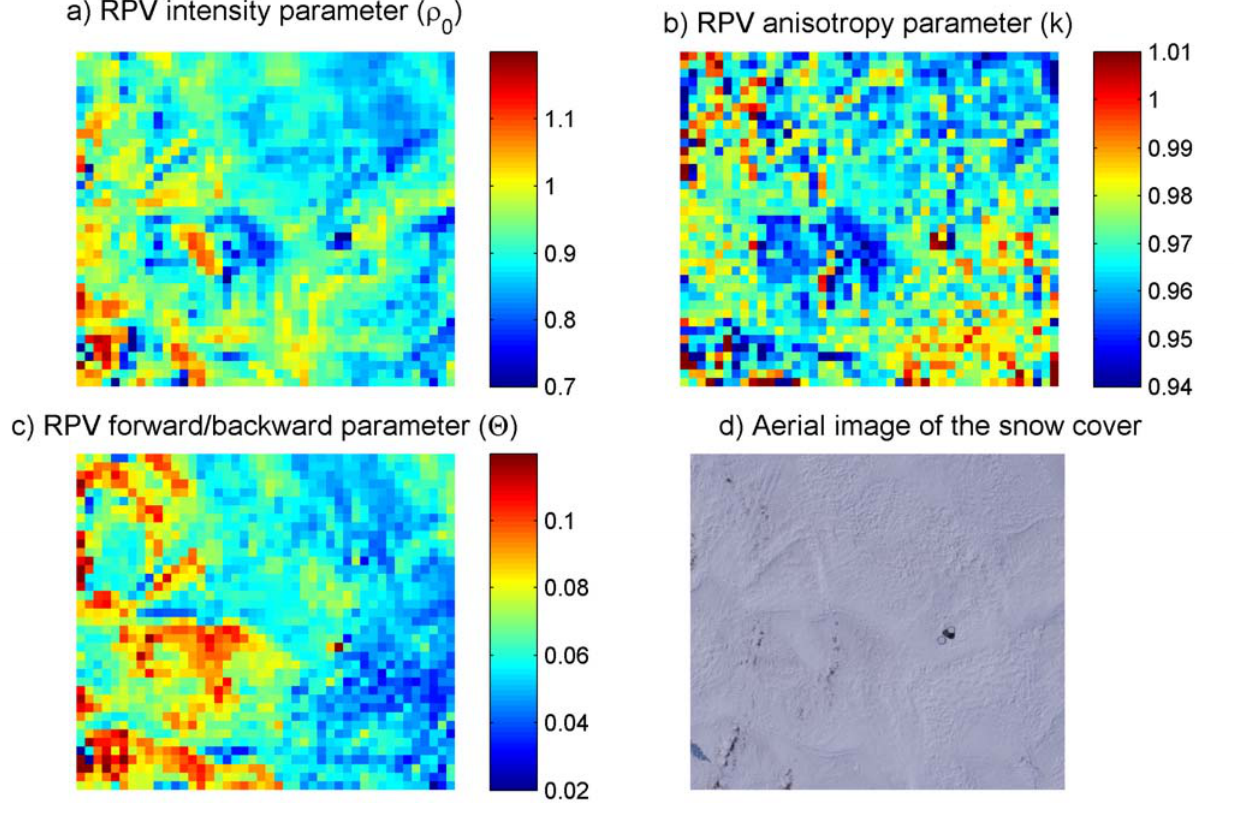
Figure 9. The Rahman Pinty Verstraete model parameter maps for the target area. The BRF data has been calculated from the images in a 50 × 50 pixel grid. Although the RPV model is not perfectly suited to model subtle variations in the snow cover, for example variations in the roughness of the snow cover can be observed by visually comparing the primary image and the parameter